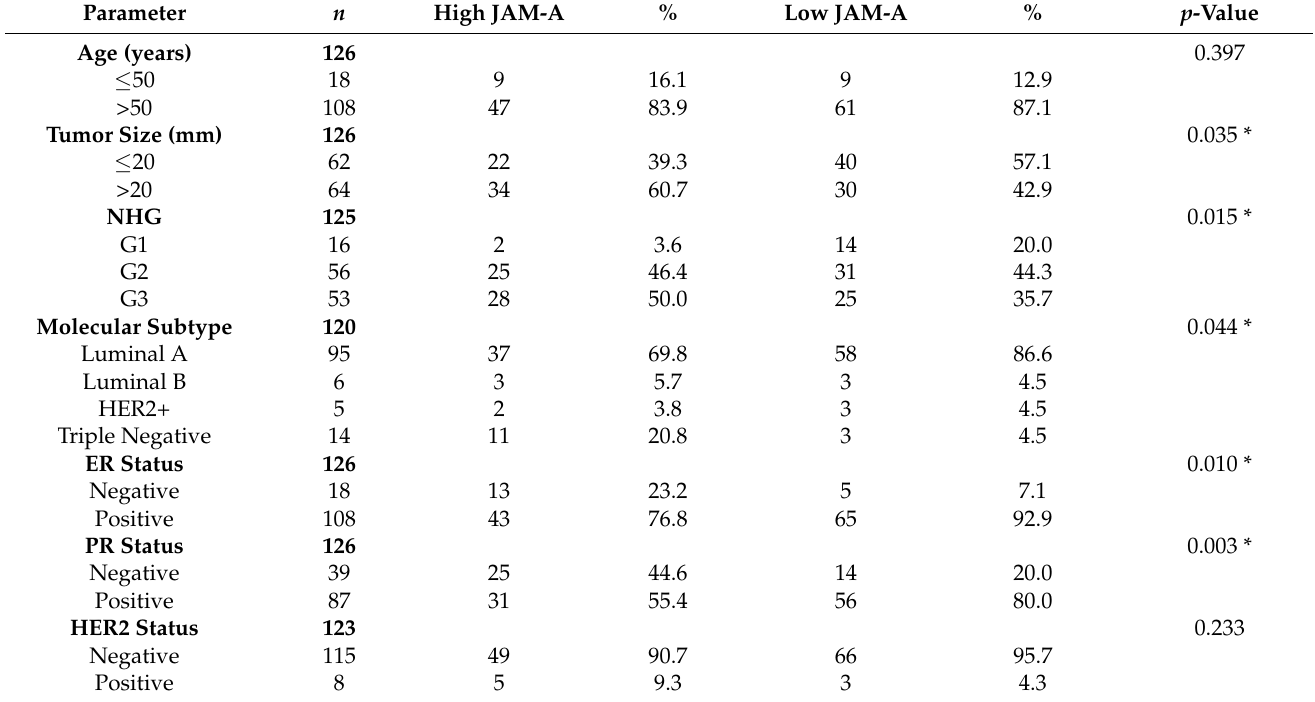
Table 1. Correlation between JAM-A high versus low protein expression with clinicopathological parameters in invasive breast cancer TMA. Individual parameters and their corresponding total patient numbers are noted in bold